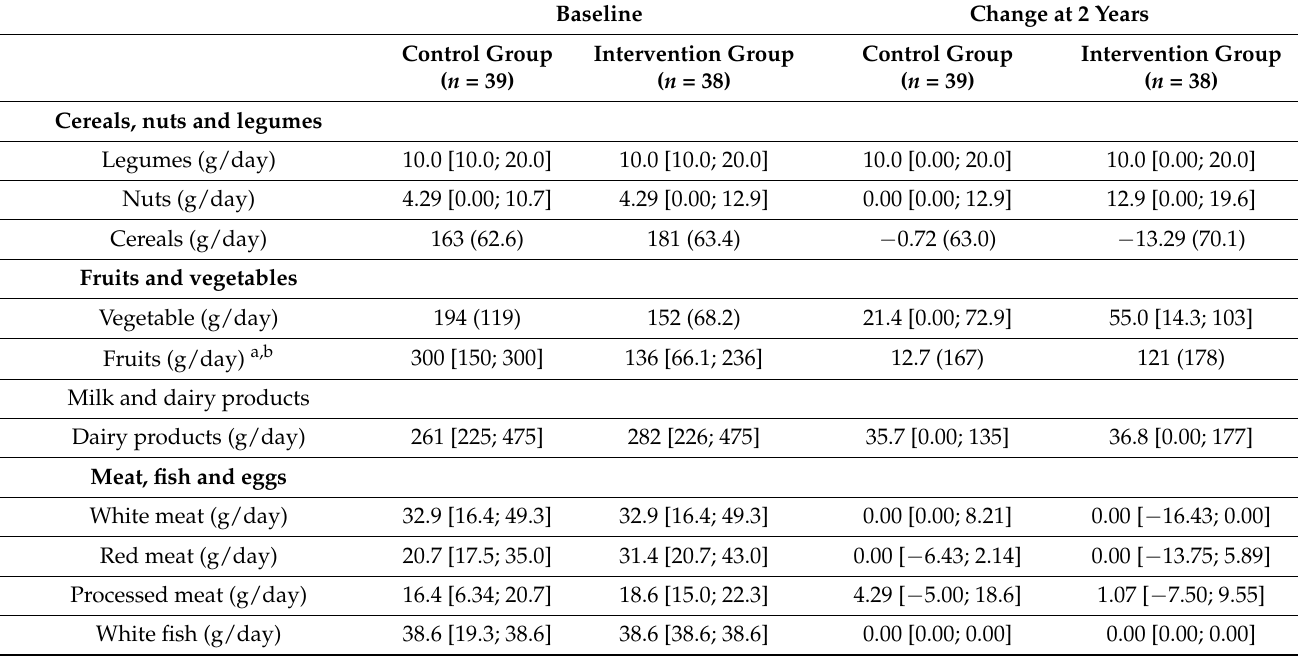
Figure 2. Participants with positive answer (%) to each of the 14 Items of MEDAS. MEDAS refers to the 14-point test of adherence to the Mediterranean diet validated by the PREDIMED study [34]: (Q1) use olive oil as main culinary fat, (Q2) olive oil > 4 tablespoons, (Q3) vegetables ≥ 2 servings/day, (Q4) fruits ≥ 3 servings/day, (Q5) red or processed meats < 1/day, (Q6) butter/cream/margarine < 1/day, (Q7) soda drinks < 1/day, (Q8) Wine glasses ≥ 7/week, (Q9) legumes ≥ 3/week, (Q10) fish or seafood ≥ 3/week, (Q11) commercial bakery ≤ 2/week, (Q12) nuts ≥ 3/week, (Q13) poultry more than red meats and (Q14) use of sofrito sauce ≥ 2/week. Data are presented with the number of answer participants’ ( n ). Negative values show the difference in the number of participants responding affirmatively to the questionnaire question at the final visit compared to the baseline visit. The McNemar test was used for analysis (test for paired qualitative variable). a p -value <0.05 when comparing data between baseline and final visit. b p -value <0.01 when comparing data between baseline and final visit. Table 2. Baseline and change at two years—consumption of different food (g/day or mL/day) of the study population, compared by